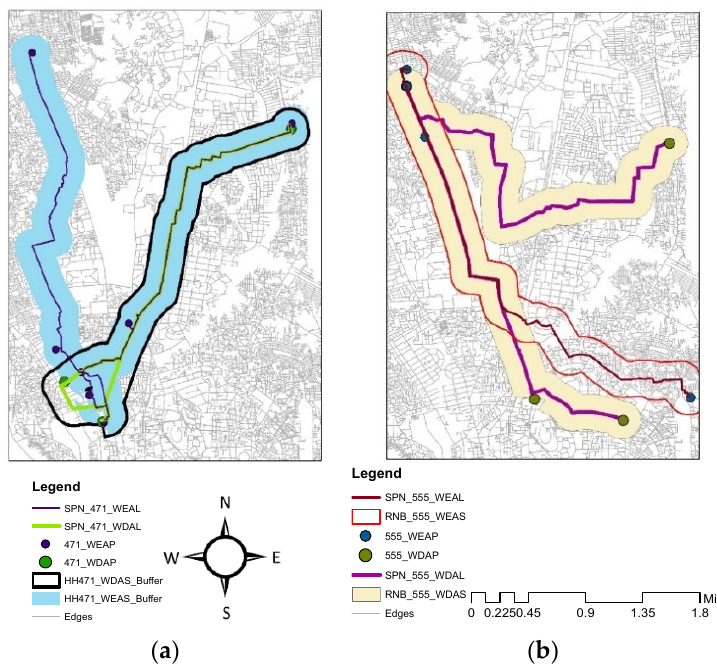
Figure 8. Visualization of WDAS (Weekday Activity Space) and WEAS (Weekend Activity Space) based on activity locations by SPN with RNB method: ( a ) an example of a 2 member HH living in Dhanmondi and ( b ) an example of a 3 member HH living in Mirpur. WEAL: weekend activity length,